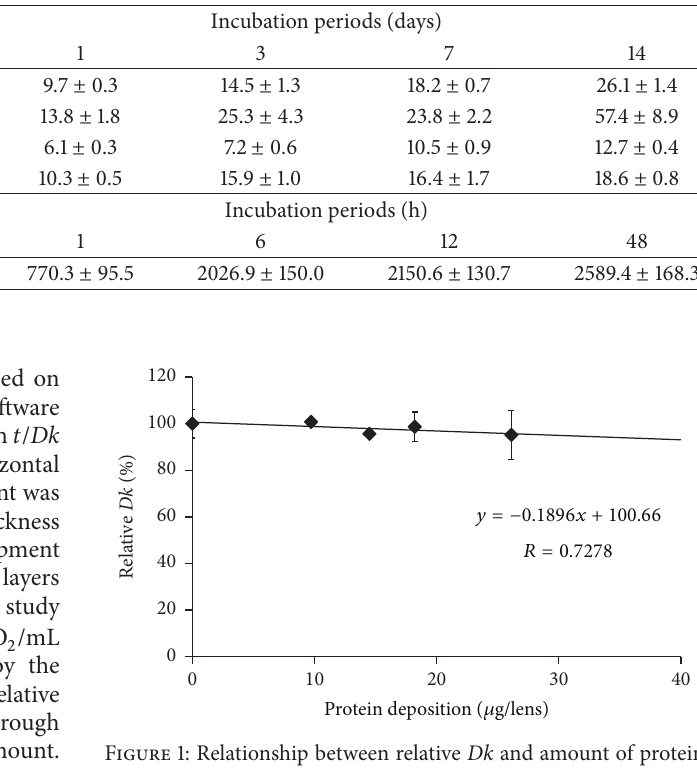
Table 2: Amount of total protein deposition after incubation in artificial tear solution.